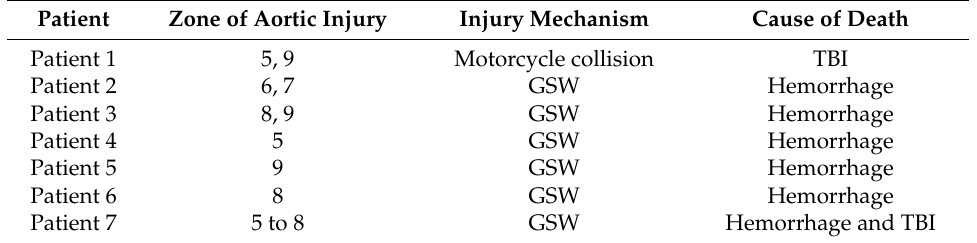
Table 4. Possibly preventable deaths who expired at the